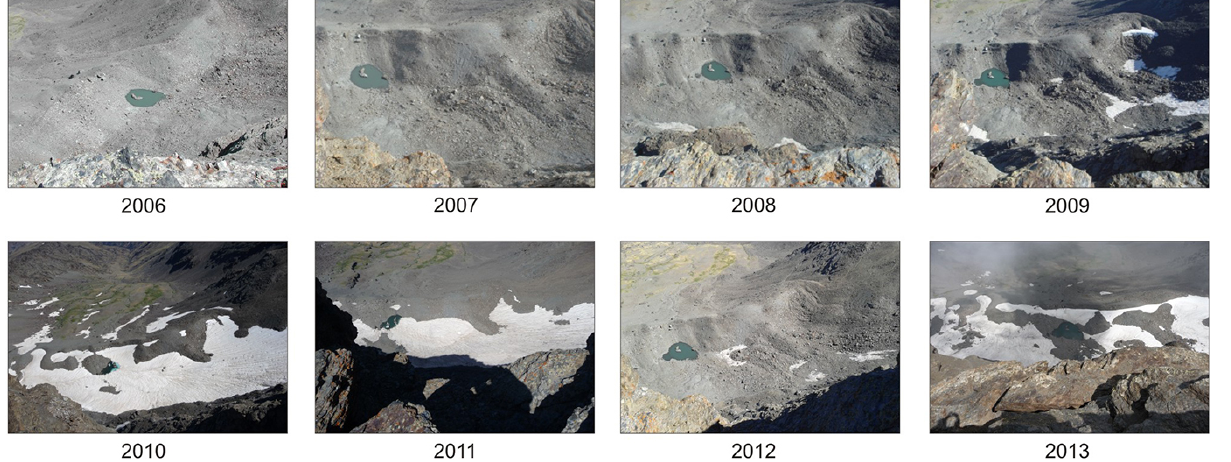
of the frozen masses at the heart of the rock glacier, a series of techniques from different disciplines were